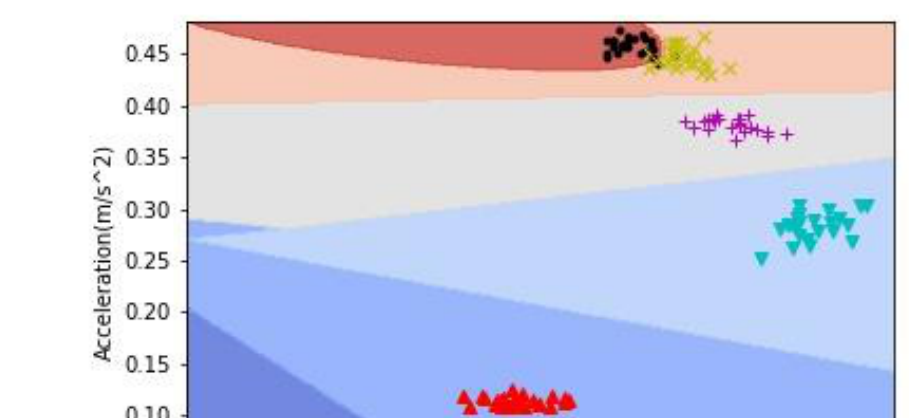
Figure 10. Decision tree branch.